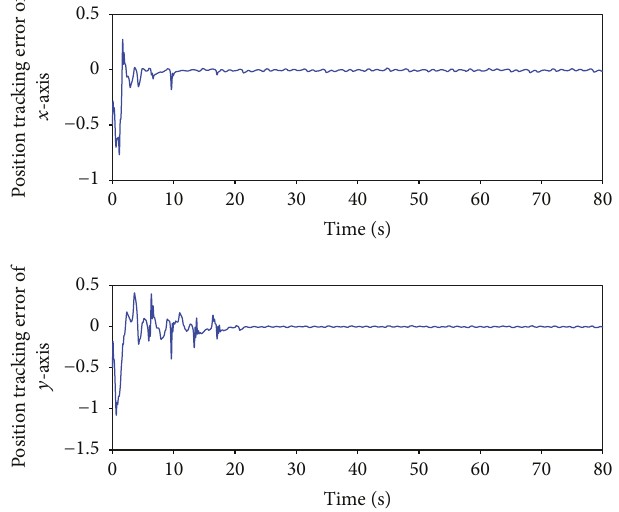
Figure 6: Tracking error using the adaptive sliding mode